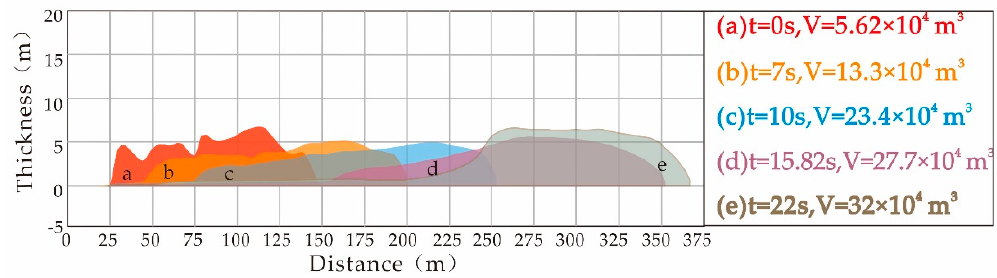
Figure 8. Variation of the thickness of the accumulation body at different times.